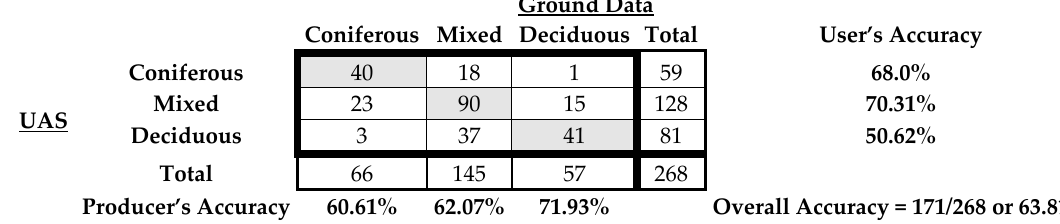
Table 6. OBC sample unit thematic map error matrix for stratified randomly distributed subsamples. Table 7. CFI plot-registered UAS orthomosaic subsample thematic map error matrix. Ground (reference) data are represented by the CFI plots and Unmanned Aerial Systems (UAS) data are derived from the corresponding orthomosaic.